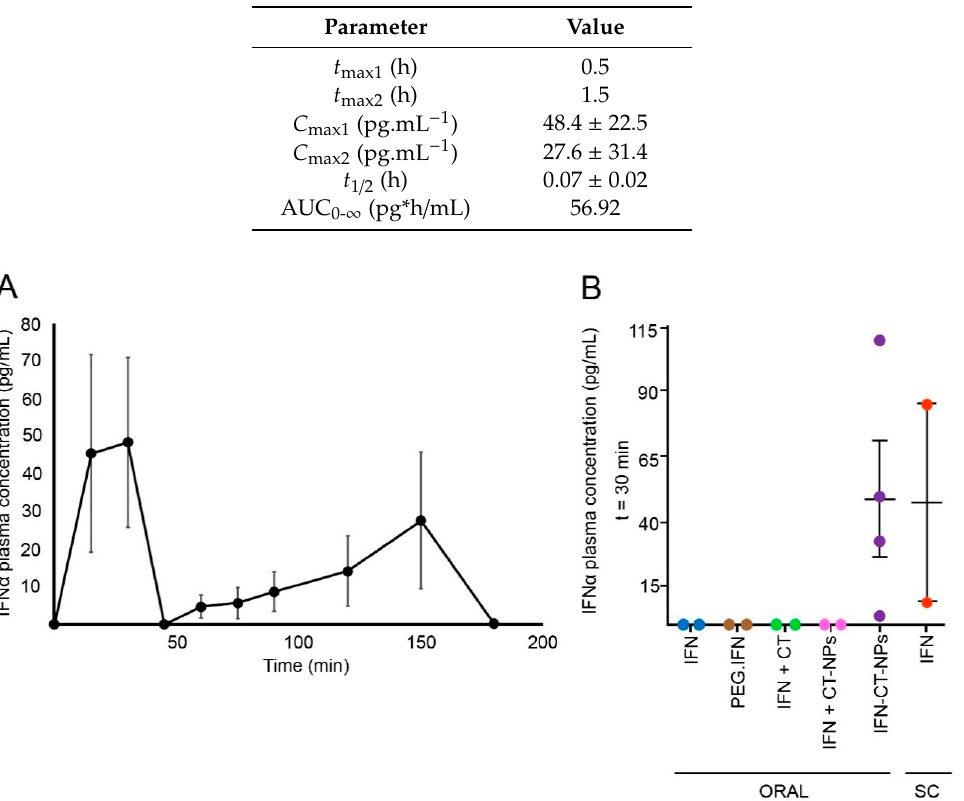
Figure 5. Oral pharmacokinetics of interferon alpha (IFN α ). ( A ) Mean plasma concentration ( ± standard error of the mean (S.E.M.))—time profile of IFN α after oral administration of IFN-CT-NPs (dose = 0.3 MIU) to BALB / c mice (n = 20) and ( B ) IFN α plasma concentration ( ± S.E.M) in mice at 0.5 h